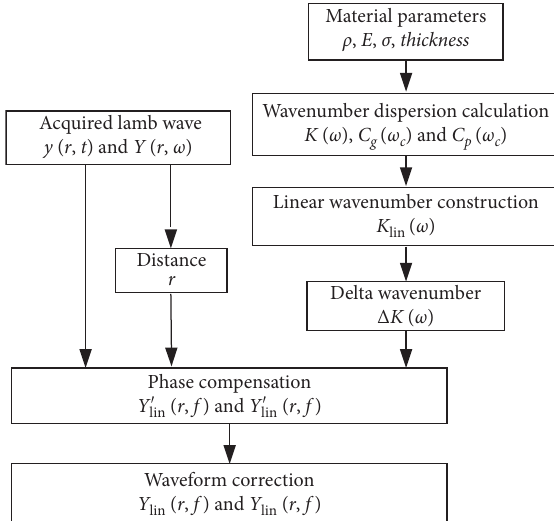
Figure 1: Schematic of ∆ K-DC for the theoretical